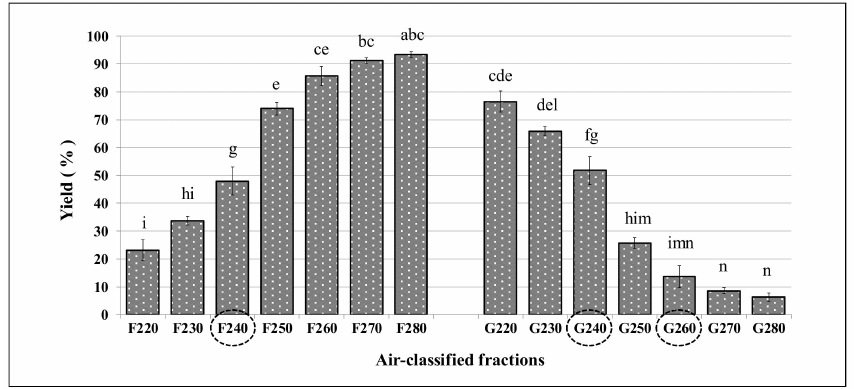
Figure 4. Mean yield percentage (%) of the air-classified fractions of samples belonging to the cultivars Saragolla, Maest à , and Iride. Different letters indicate statistically significant difference ( p < 0.05, n = 3). Circles highlight the fractions with significant differences ( p < 0.05) among cultivars (n =